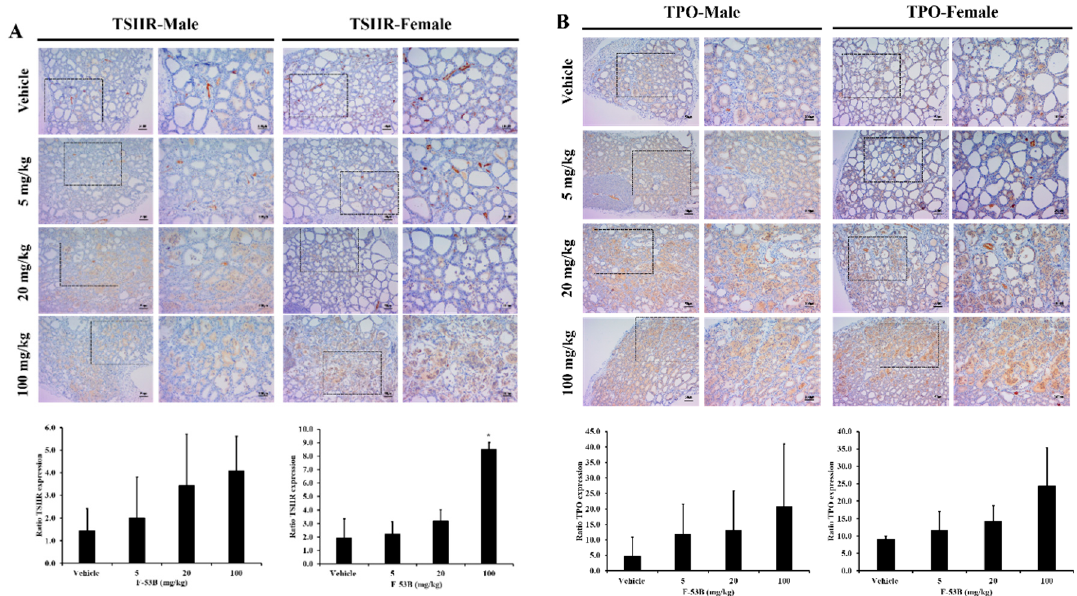
Figure 5. Immunostaining of thyroid hormone biosynthesis-associated proteins in the thyroid gland tissue of F-53B-treated rats. Thyroid tissues were stained with thyroid-stimulating hormone receptor (TSHR) ( A ) and thyroperoxidase (TPO) ( B ) specific antibodies to confirm the localization and expression of the proteins in male and female rats. The data are displayed as the mean ± s.d. For values that differ significantly as assessed by one-way analysis of variance and Dunnett’s test: * indicates p < 0.05 compared with the vehicle control group.